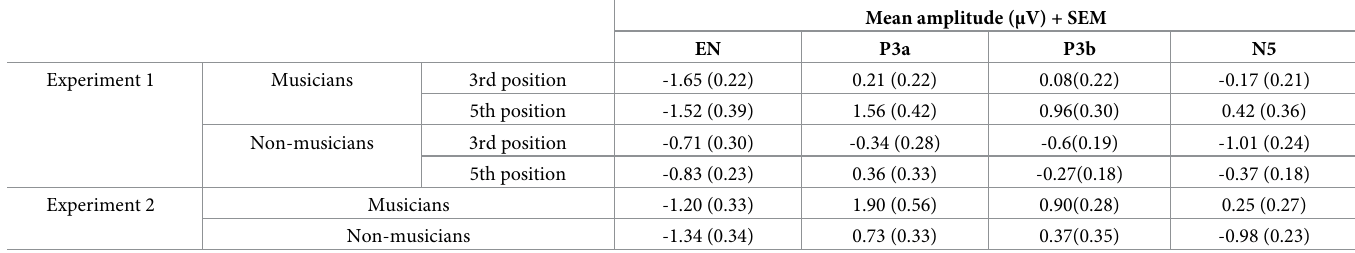
Table 1. Mean amplitudes and SEM for the ERPs of interest. Mean amplitudes reported are the grand-average of the mean amplitude of the difference waves calculated within each time window of